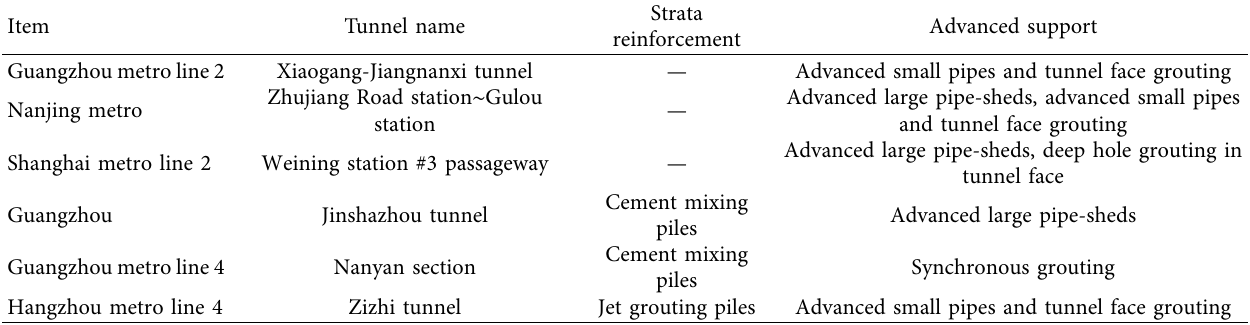
Table 1: The support system of urban shallow tunnels in silty soil in recent years in China.